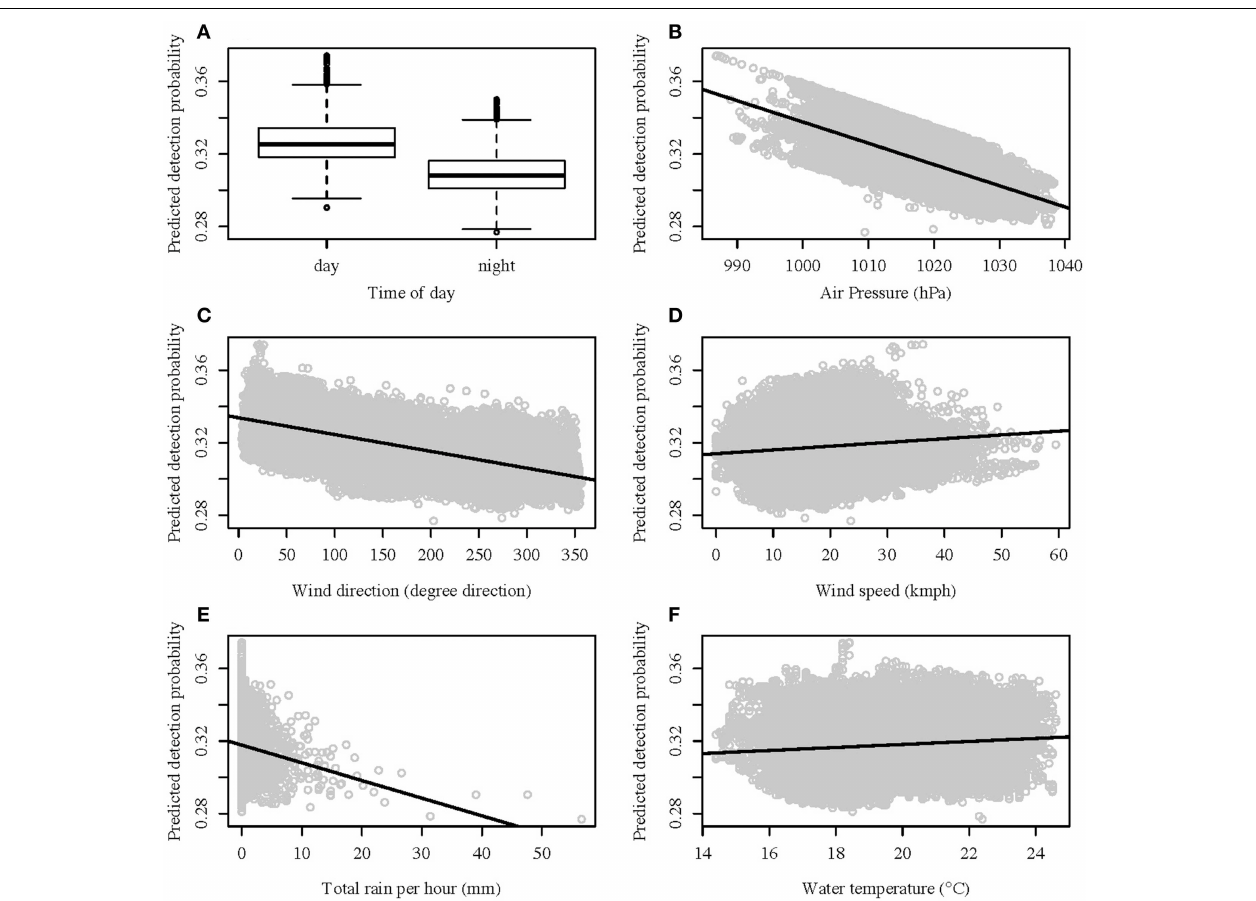
FIGURE 2 | Predicted detection probability values against best predictors: (A) time of day; (B) air pressure; (C) wind direction; (D) wind speed; (E) rain; and (F) water temperature.